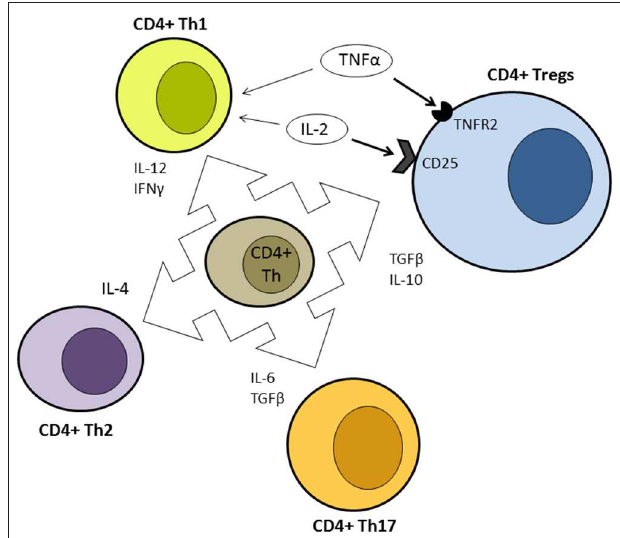
FIGURE 2 | Simplified representation of the differentiation ability of uncommitted CD4 + T helper according to different cytokine stimulation. Contrasting effects of IL-2 and TNF α are highlighted. Bold arrows indicate prevalent effect at low concentration. Th, T helper; Tregs, regulatory T